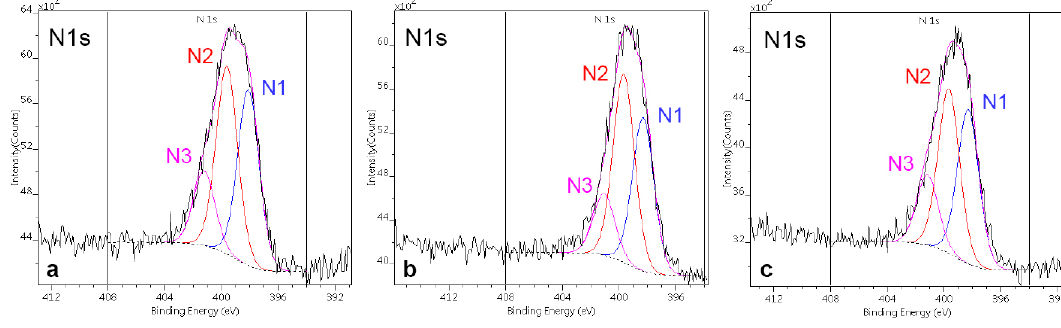
Figure 6: Decomposition of the N1s lines of the HOPG (a), GR (b) and SLGO (c) samples treated at 100 V